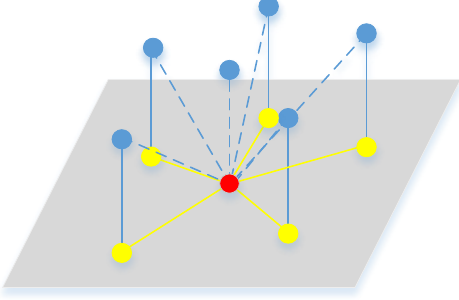
Figure 4. Graph model relations based on CRF.